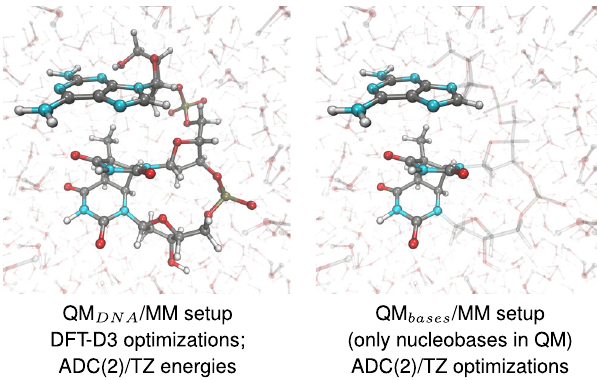
Fig. 7 QM/MM setups used in the geometry optimizations and energy calculations. Solid balls and sticks models show the two considered QM regions, while transparent residues (water molecules in both setups and the sugar-phosphate backbone on the right) correspond to the MM region described at the force- fi eld level. The MM region interacts with the QM part via point charges (electrostatic embedding). ADC(2)/TZ denotes the ADC(2) method with the TZVP basis